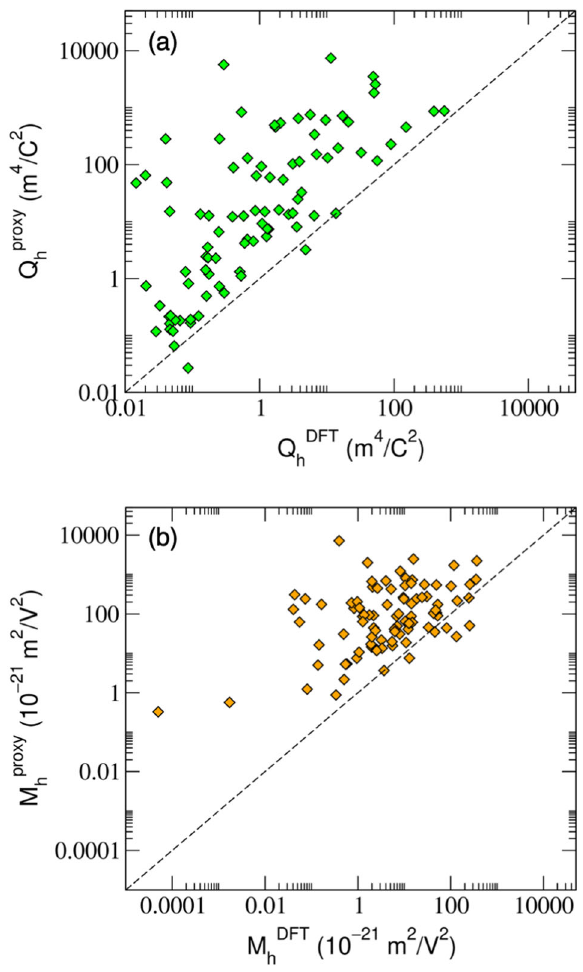
Fig. 3 Comparison of electrostrictive coef fi cients of Q h and of M h obtained from proxy and DFT computation. Comparison of a Q DFT h versus Q proxy and b M DFT versus Q proxy obtained from direct h h h application of the empirical formula to the Materials Project data and our DFT